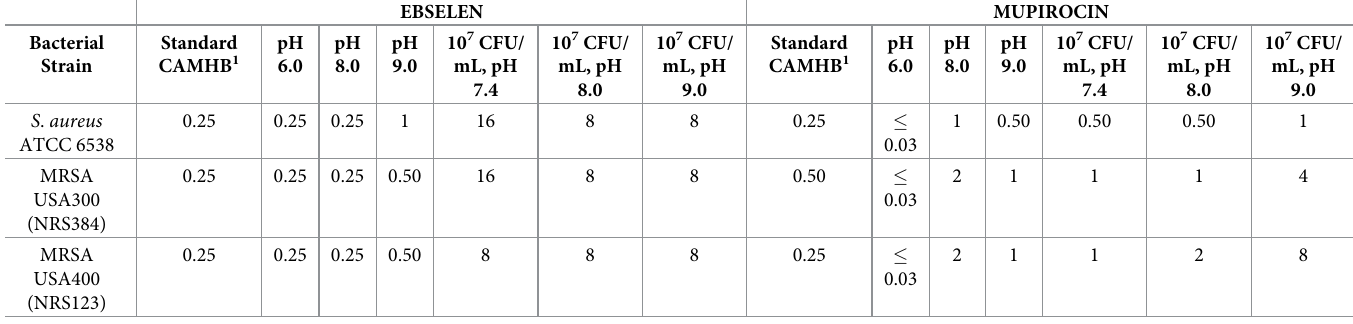
Table 2. Minimum inhibitory concentration (MIC in μ g/mL) of ebselen and mupirocin determined against three strains of Staphylococcus aureus in the presence of different pH and high bacterial